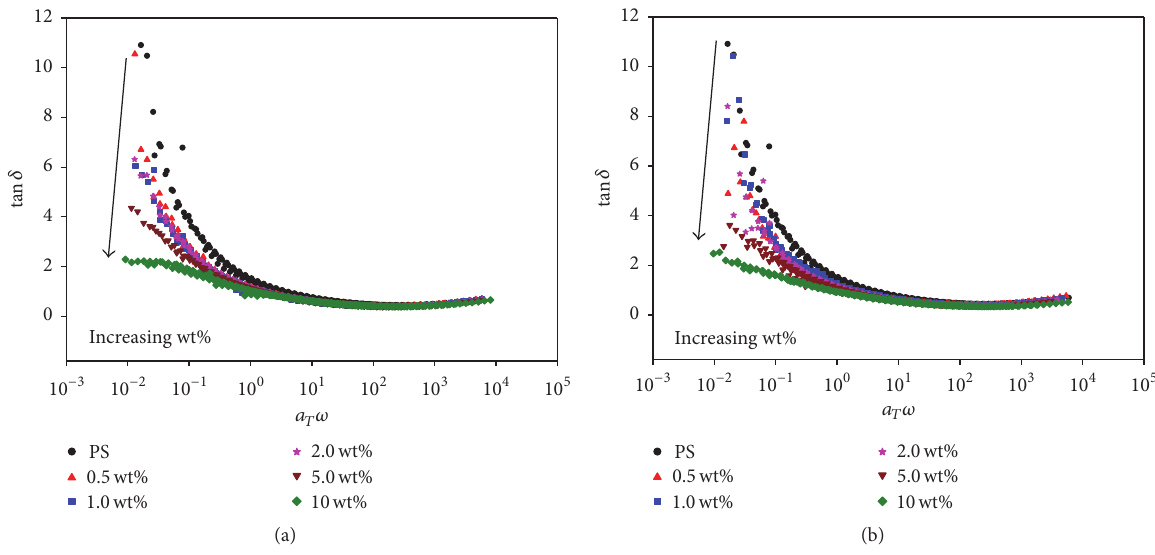
Figure 5: tan 𝛿 plot of (a) PS/nanofiber and (b) PS/nanosheet blend in terms of angular frequencies with varying nanofiller loading.